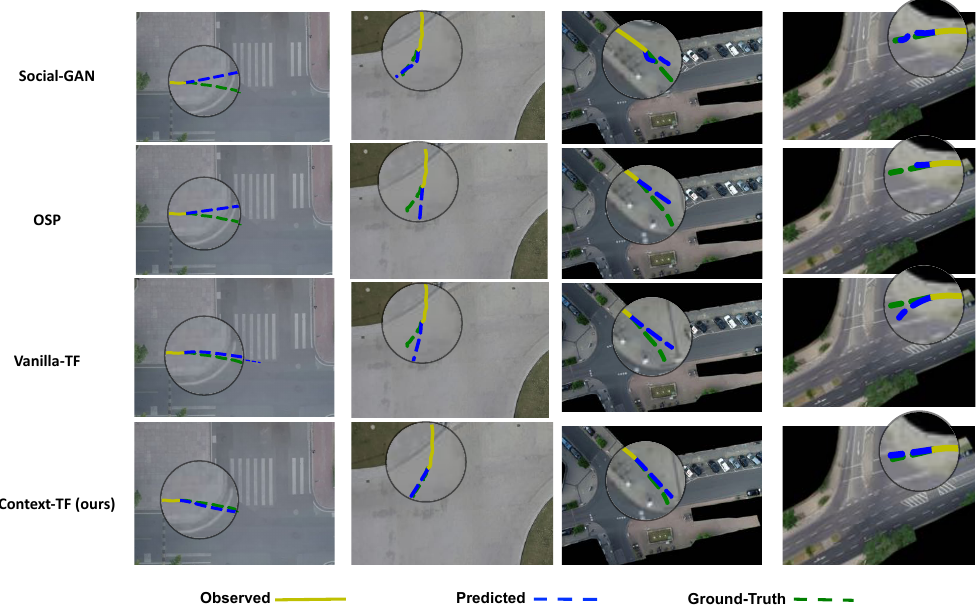
Figure 4. Sample output predictions of our proposed framework ‘Context-TF’ two different scenes from the DUT dataset (first two columns) and the inD dataset (second two columns). The observed short trajectory (3 s) is visualised in solid dark yellow, the predicted trajectory (5 s ahead) is in dashed blue and the ground-truth trajectory visualised in dashed